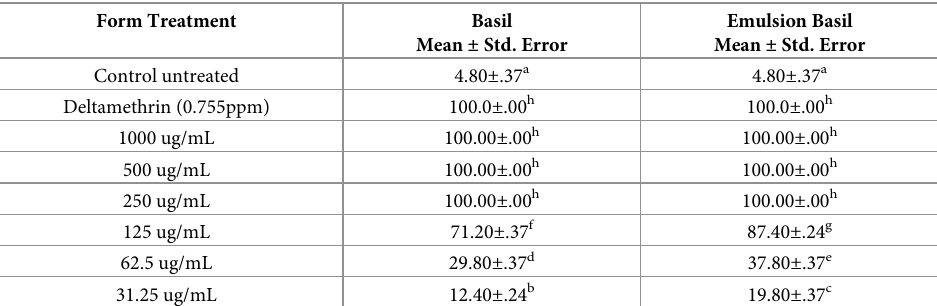
Table 3. Mean of larval mortalities after treatment with basil and its emulsion form after 24 hours application on the fourth larval stage of laboratory-reared Culex pipiens . Form Treatment Basil Mean ± Std.